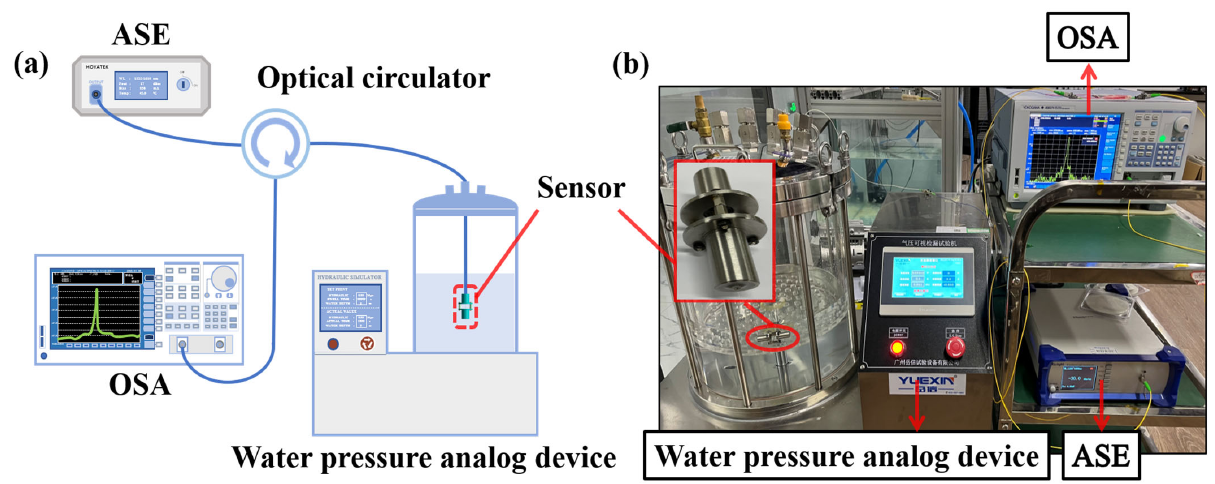
Figure 4. Fabrication process of the proposed sensor.